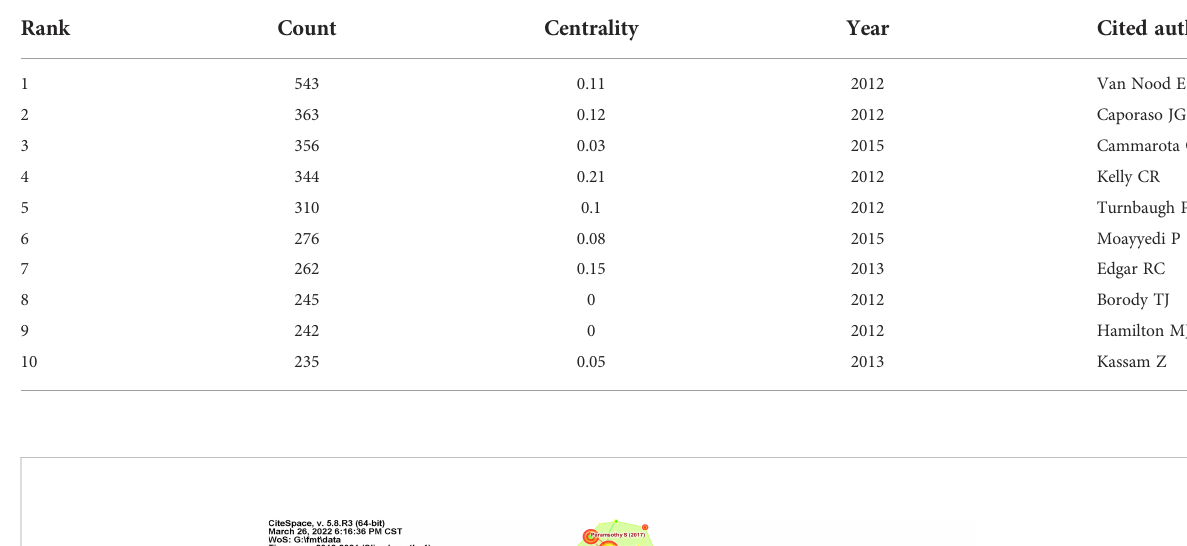
TABLE 6 Top 10 cited authors related to FMT research.